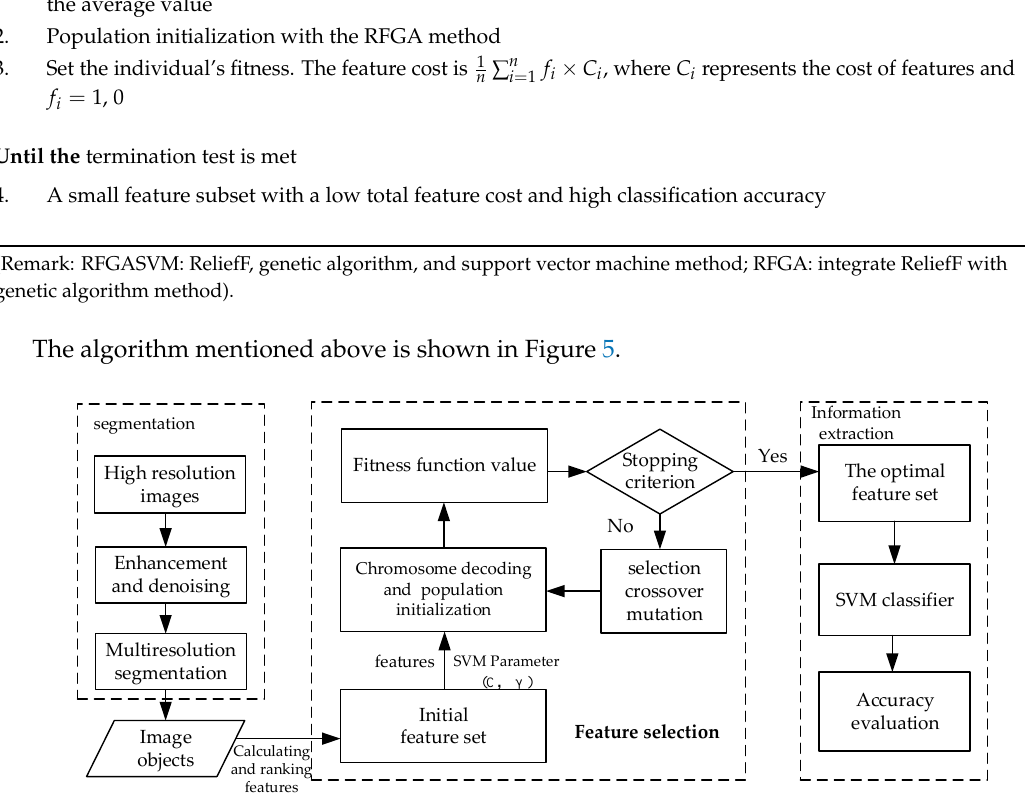
Figure 5. Flow chart of the extraction of house information based on the RFGASVM optimization algorithm.